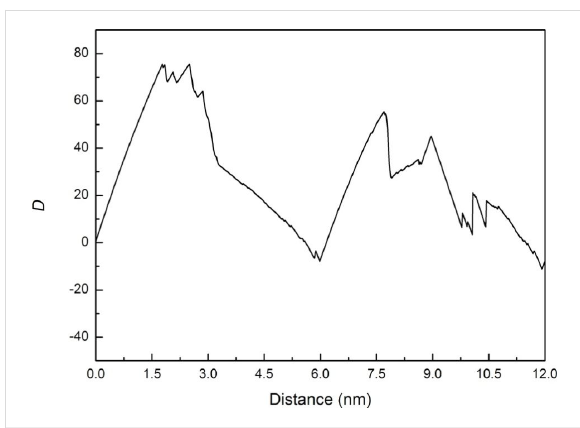
Figure 7: Force–distance curve of Fe under two times of cyclic loading, where the tension and compression distances of the sample are 3